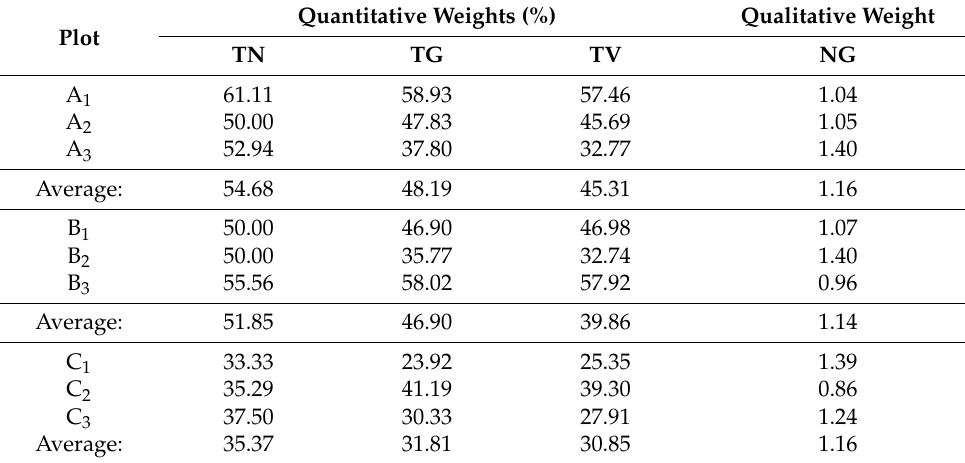
Table 2. Quantitative and qualitative weights of the thinning levels applied to laurel in the Traditional Agroforestry System, Sumaco Protected Forest.